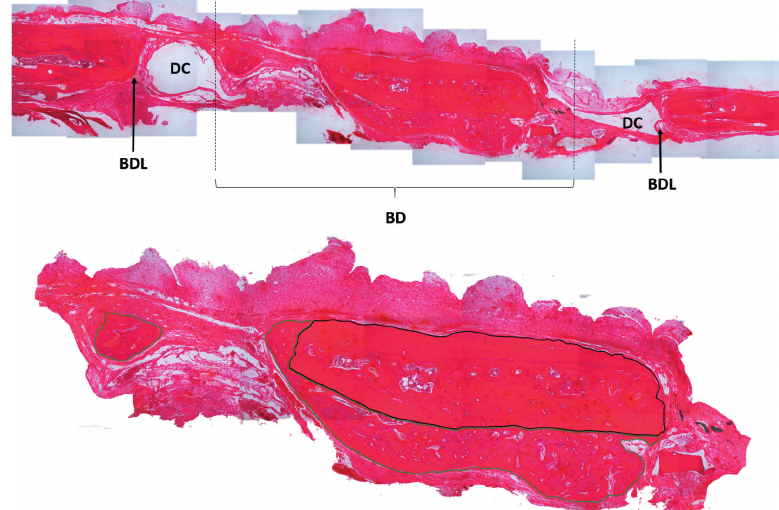
Figure 2- Mosaic-like arrangement of the entire length of the bone defect and central portion of the defect. Superior image: BDL indicates the bone defect limit, DC indicates position of the metal device used (magnet or titanium disk), BD indicates the bone defect area; Inferior image: it shows the image obtained for histomorphometric analysis after exclusion of areas outside the critical bone defect created; the black line delimits the autogenous bone graft and the green line delimits the new bone